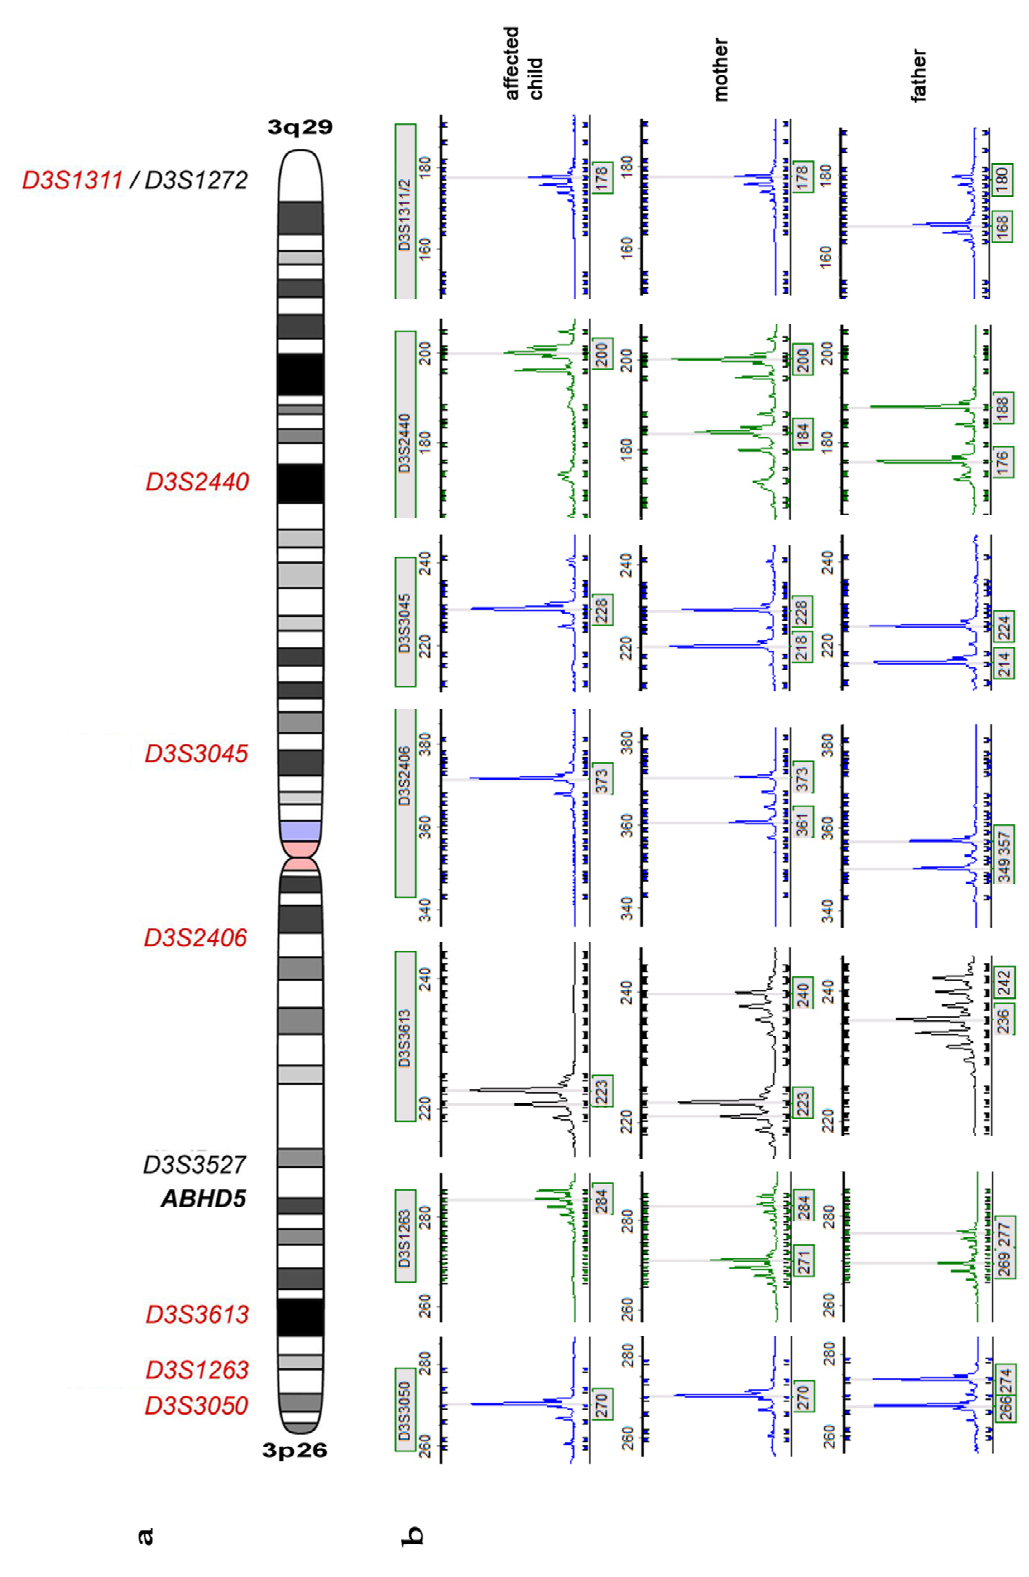
Figure 2. ( a ) Schematic presentation of chromosome 3 and the location of the ABHD5 gene (bold italic) with the analyzed microsatellite markers (italic); red = maternal UPD in the affected child; black = marker not informative. ( b ) Presentation of Microsatellite marker analysis of all informative markers. The affected child has no paternal allele and therefore did not inherit chromosome 3 of the father. The affected child shows one of the maternal alleles, suggesting a maternal